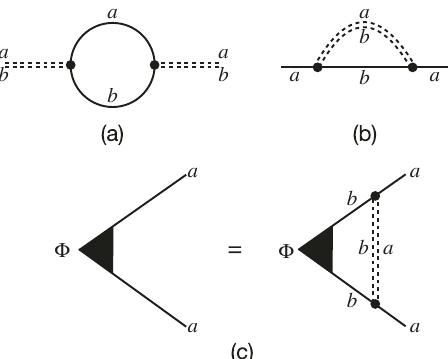
Fig. 3 Diagrams of the large − N expansion for the coupled electron-phonon model. Self-energy for the a phonon ( X ab ), and b electron ( c a ) fi elds, respectively. c Bethe-Salpeter equation for the pairing vertex, Φ . Double dashed and solid lines represent the phonon and electron fi elds. Solid circles (triangles) denote the electron – phonon (pairing)